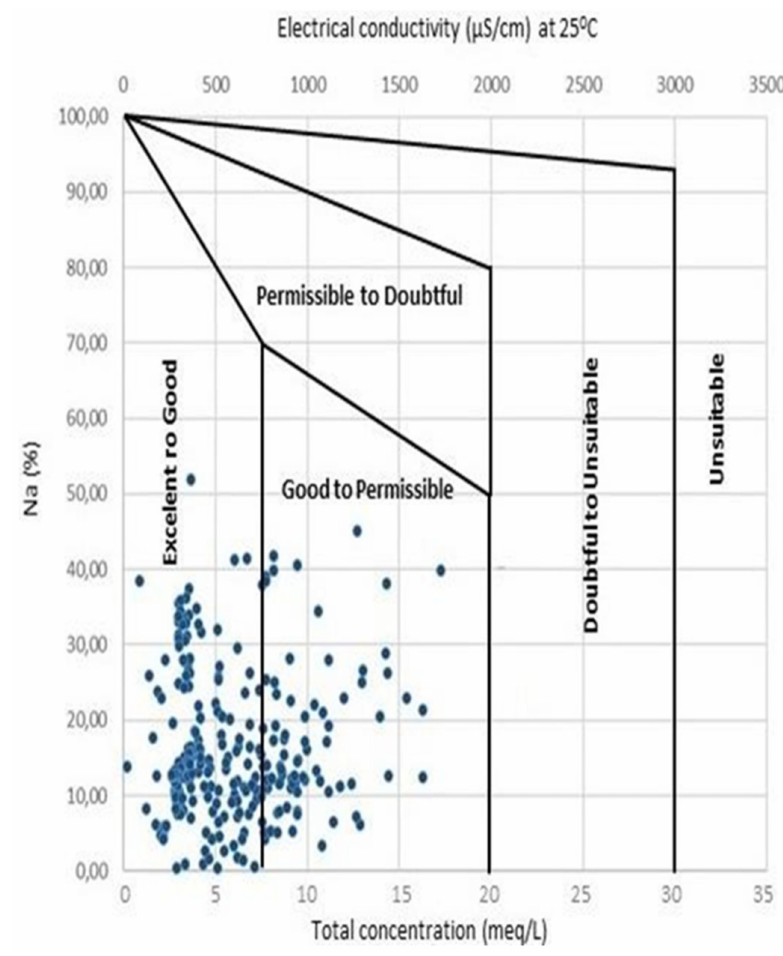
Figure 8. The plot of sodium percentage versus electrical conductivity